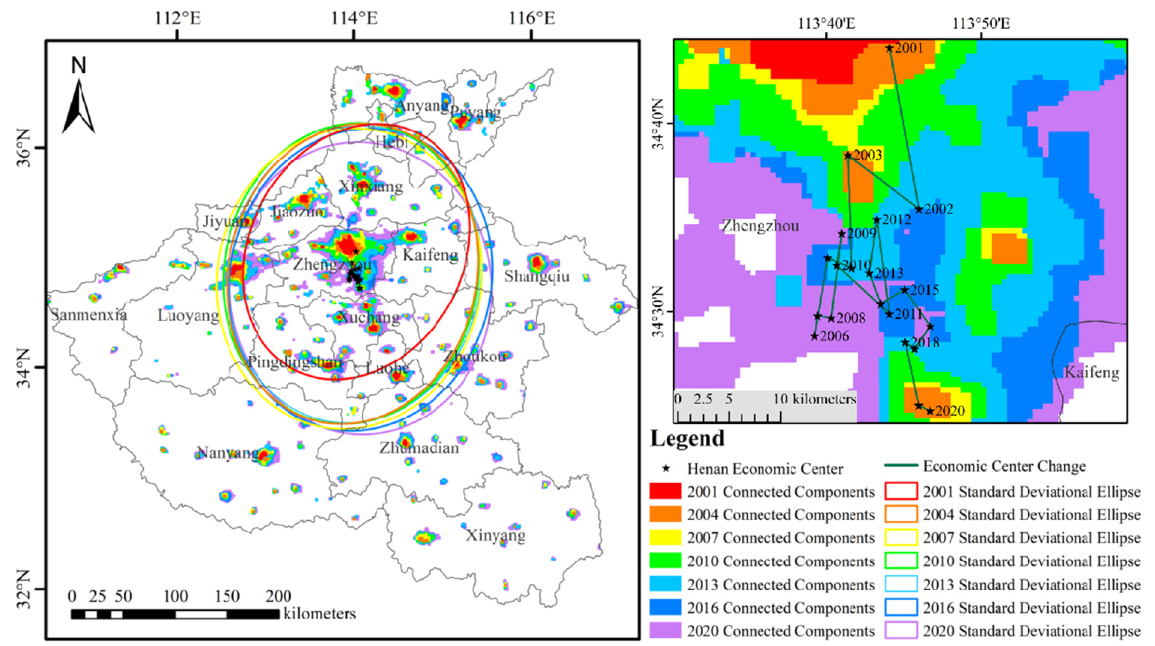
Figure 14. Henan weighted standard deviation ellipses, economic centers, and trends in economic center change, for GDP spatialization data.